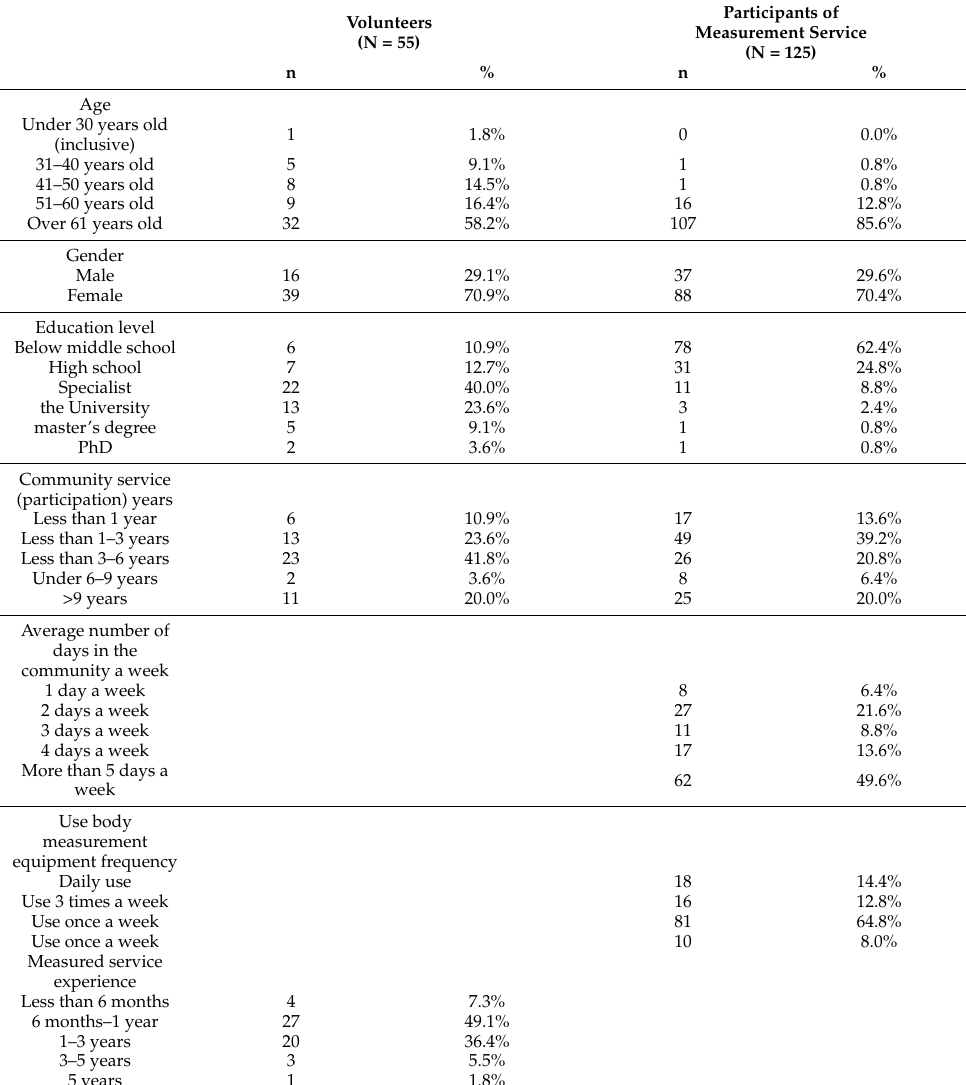
Table 2. Descriptive statistical